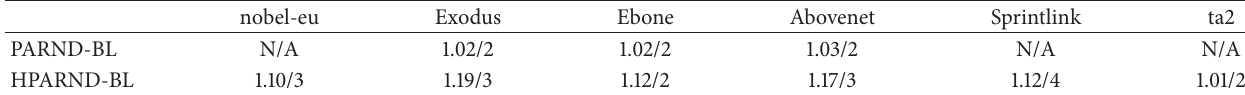
Table 12: Number of paths per flow (Avg/Max)—logarithmic curve. nobel-eu Exodus Abovenet